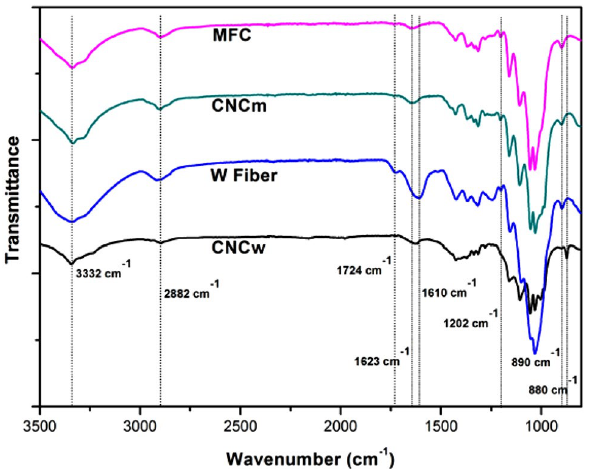
Fig. 4 TGA thermograms of the water hyacinth fibers (W fiber), the microfibrillated cellulose (MFC), the water hyacinth-based cellulose nanocrystals (CNC w ), and the MFC-based cellulose nanocrystals (CNC m